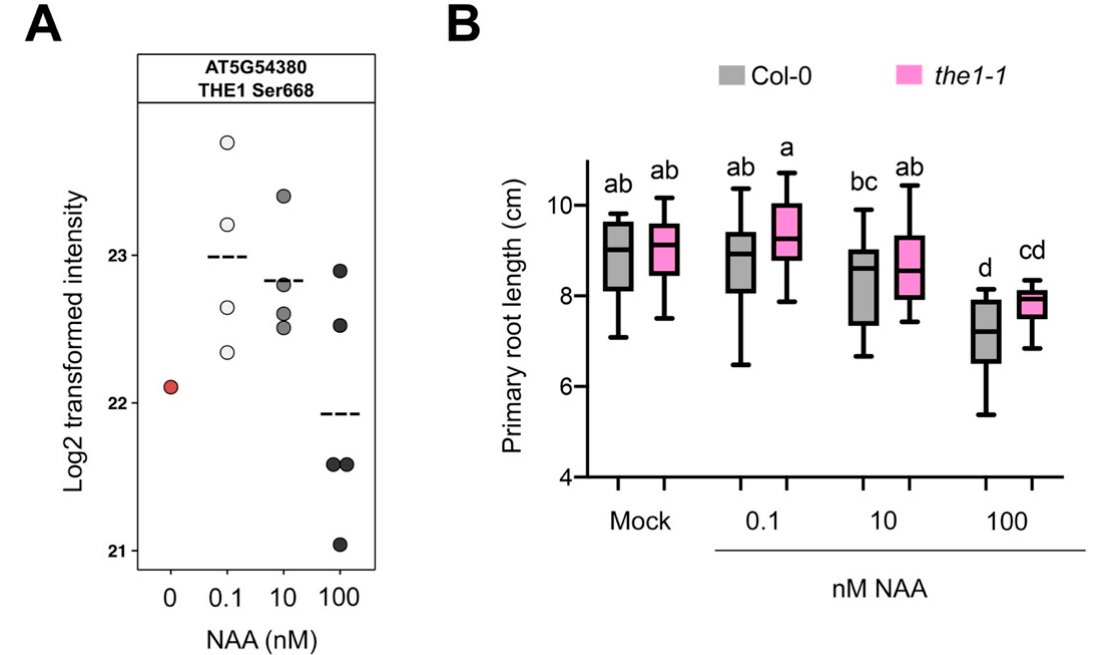
Figure 3. THE1 impacts NAA-controlled primary root growth. ( A ) THE1 phosphoprofile for the TGPSLDQT(0.007)HVS(0.959)T(0.034)AVK phosphopeptide upon NAA treatment. Dashed line indicates mean. Each dot is a biological replicate. ( B ) Primary root growth of 11-day-old the1-1 seedlings in response to different concentrations (n = 18–30 seedlings). Boxplots show average with Tukey-based whiskers. Letters indicate significant difference according to two-way ANOVA with Tukey post-hoc test ( p < 0.05).